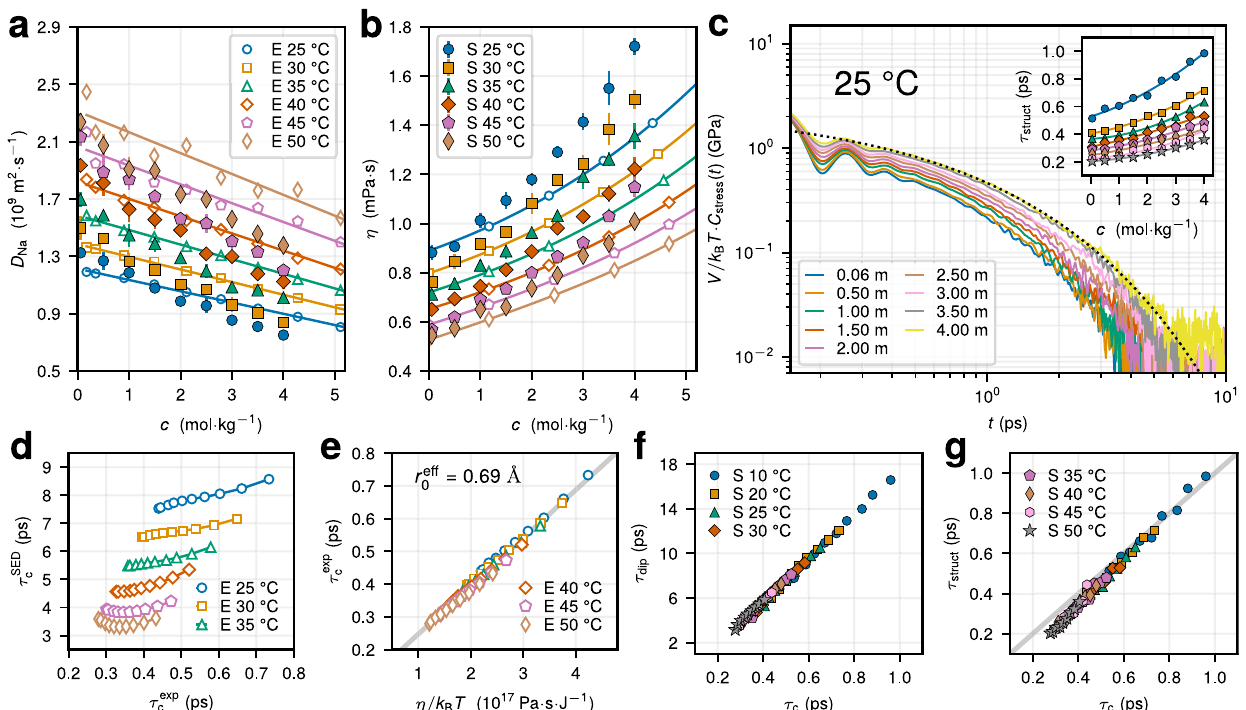
Fig. 5 | Assessing models of the quadrupolar relaxation. a Na + diffusion coef fi - cient as a function of salt concentration c for different temperatures T in experi- ments (open symbols, legend shown in a ) and simulations ( fi lled symbols, legend shown in b ). b Dynamic solution viscosity as a function of c for different T in experiments (open symbols, legend shown in a ) and simulations ( fi lled symbols, legend shown in b ).Experimental viscosities were taken from ref. 60. Solid lines in a , b are polynomial fi ts of the experimental data. c Stress tensor ACFs C stress ( t ) normalized bythe system volume V and k B T for increasing C at T =25°C.The black dotted line shows the stretched exponential fi t of the long-time decay at c =4m. Inset: the time scale of solution structural relaxation τ struct , as extracted from the long-time decay of C stress ( t ) (see main text), as a function of c at